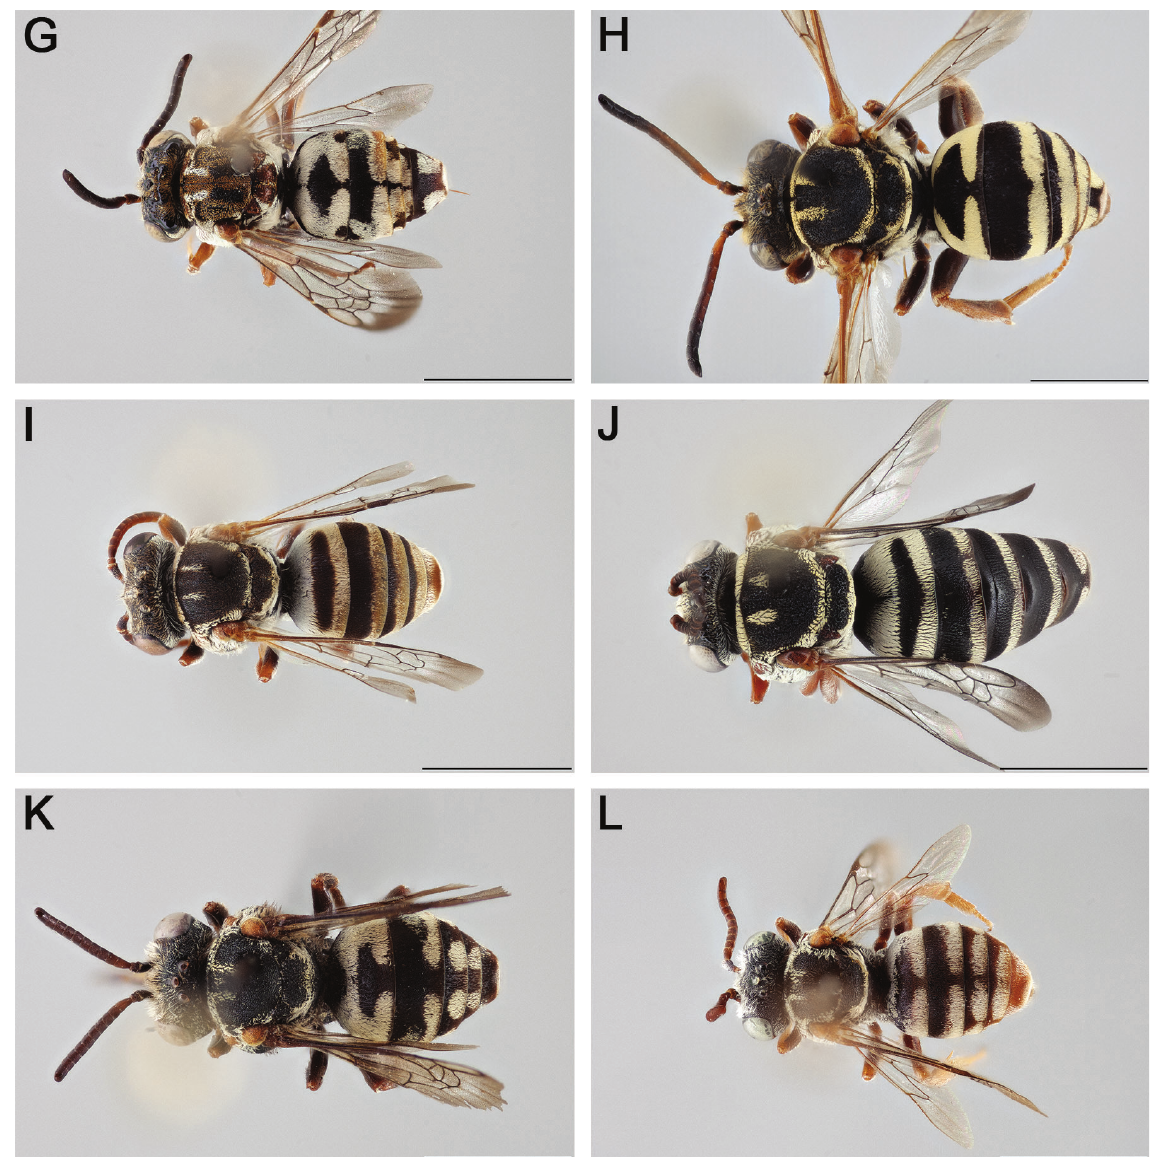
Fig. 22G–L (continued). Epeolus spp., habitus of female, dorsal view. G . E. chamaesarachae Onuferko, 2018, paratype. H . E. flavofasciatus Smith, 1879. I . E. mesillae (Cockerell, 1895). J . E. brumleyi Onuferko, 2018, paratype. K . E. asperatus Cockerell, 1910. L . E. barberiellus Cockerell, 1907. Scale bars = 3